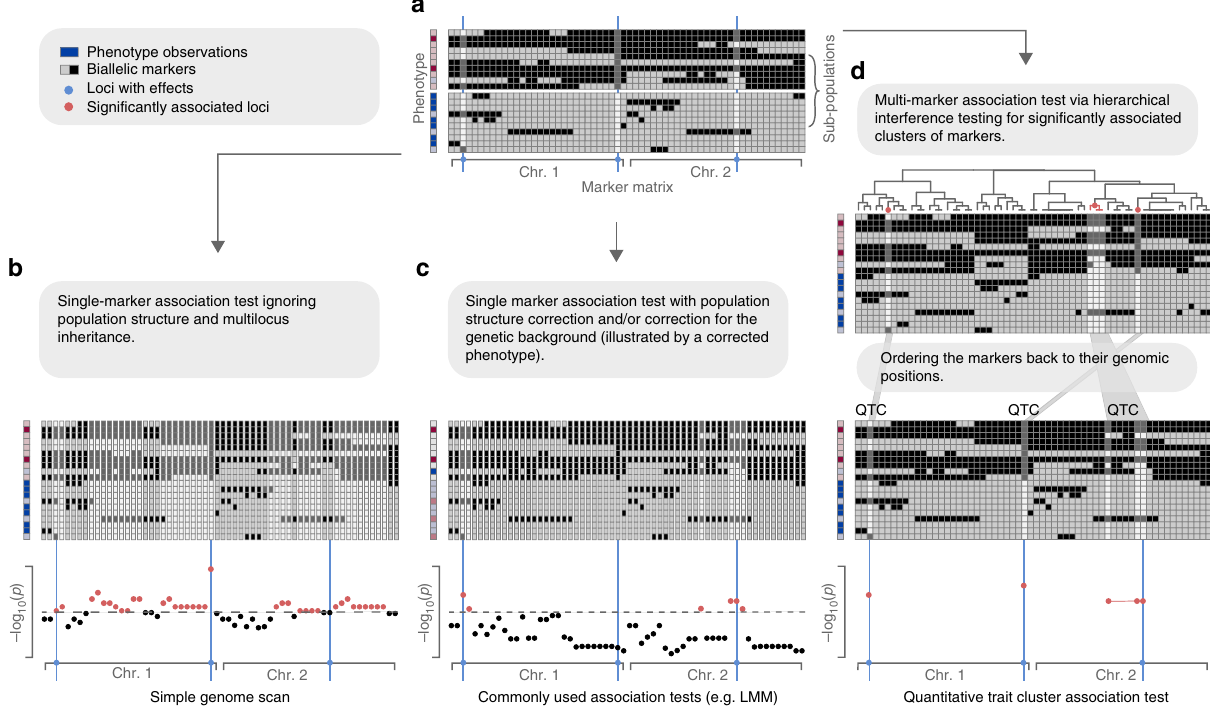
Figure 1 | Schematic of QTCAT’s workflow and other common methods. ( a ) A marker matrix representing individual genotypes (rows) of a population with two alleles (light and dark gray) per marker (columns). The population consists of two distinct subpopulations, where the individuals of each subpopulation are highly related. The loci of the markers with effects on the phenotype (causal loci) are highlighted in blue. The phenotype is shown on the left; the phenotypic values rank from dark red (if all three causal loci carry the dark grey allele) to dark blue (if all the loci carry the light grey allele). ( b ) A simple genome scan testing for associations between the phenotype and individual makers without considering population structure or genetic background. This results in a large amount of false, but significant associations due to the correlation of the markers. ( c ) Associations tests between single markers and the phenotype, while controlling for population structure and genetic background (illustrated by a corrected phenotype). This results in a drastic reduction of false associations; however, also some of the real associations cannot be identified. ( d ) Simultaneous association of all markers against the phenotype, while considering the correlations between the markers. First, all markers are clustered according to their correlation. All possible clusters of markers (that is, all nodes of the clustering tree) are then hierarchically tested for their significant association to the phenotype. All smallest clusters that are significantly correlated to the phenotype are reported as QTCs. In addition, the significant association of a QTC will suppress the association of other clusters to the same part of the phenotypic variation and thereby avoids false associations, including those introduced by population structure. This allows associating markers and phenotype without the restrictive effects of population structure correction and corresponds well with the multi-genic inheritance of complex